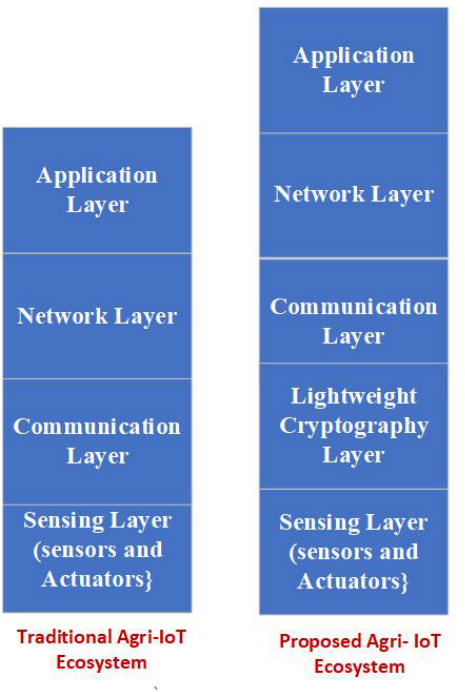
Figure 2. Traditional Agri-IoT ecosystem versus proposed Agri-IoT